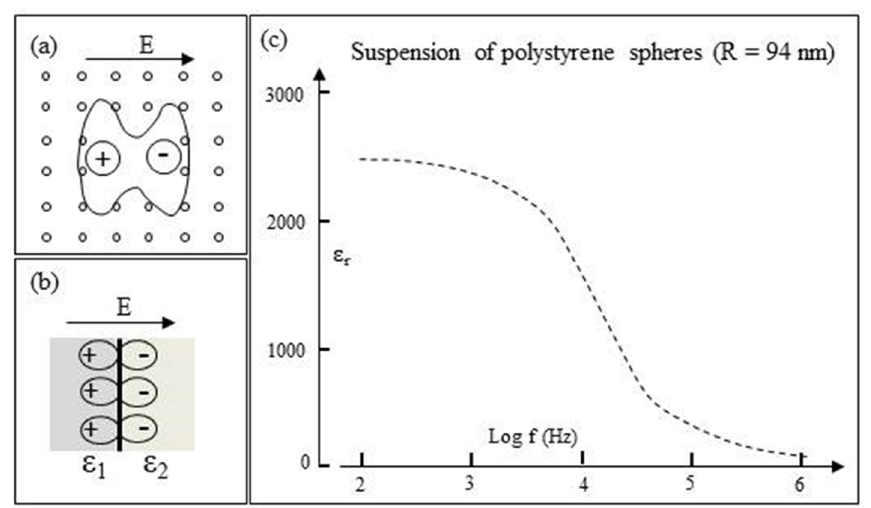
Figure 10. ( a ) Schematic of a dipole formed at the site of a structural defect in a molecular lattice. An example could be the disruption of the hydrogen bond network in bulk water at a protein–water interface—with the possible creation of ferroelectric nanodomains [66]. ( b ) Dipole polarization at a boundary of dielectric inhomogeneity. A solvated protein, with its bound water and surrounding bulk water, represents an inhomogeneous dielectric [68]. ( c ) Dielectric dispersion exhibited by an aqueous suspension of polystyrene nanospheres (R = 94 nm) (based on Schwan et al. [69]).